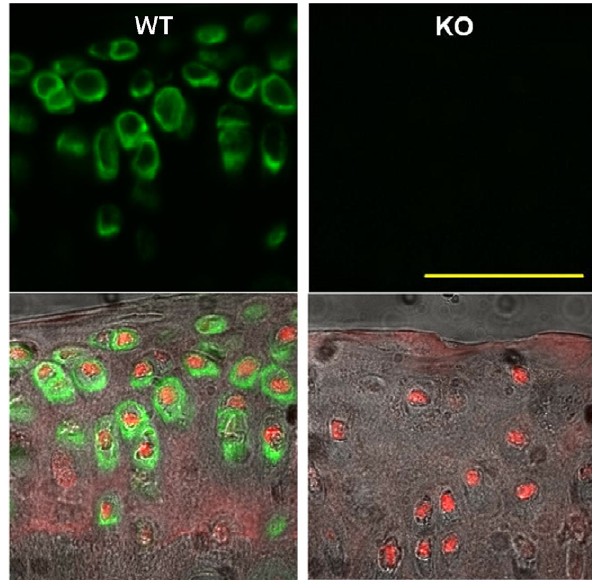
Figure 1. Immunolabeling for collagen VI in the articular cartilage of the mouse tibial plateau cartilage. Top row: Collagen VI is found exclusively in the pericellular region of chondrocytes in the wild-type PCM (left). Bottom row: Corresponding DIC images overlaid with collagen VI labeling (green) and nuclear staining (red). Cartilage of the Col6a1 2 / 2 mice (right) shows no labeling for collagen VI. Scale bar, 50 m m. WT= Col6a1 + / + ; KO= Col6a1 2 / 2